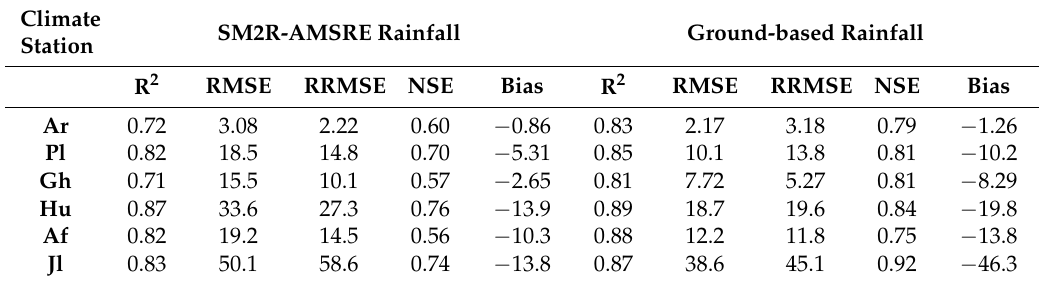
Figure 7. Observed and SWAT- simulated monthly streamflow for the 6 KRB gauge stations obtained using (1) ground-based, (2) satellite-based rainfall SM2R-AMSRE and the two direct satellite-estimated, (3) TRMM-3B42, and (4) TRMM-3B42RT rainfall products. Table 7. Performance measures for SWAT-predicted runoff with ground-based and SM2R-AMSRE rainfall. Climate